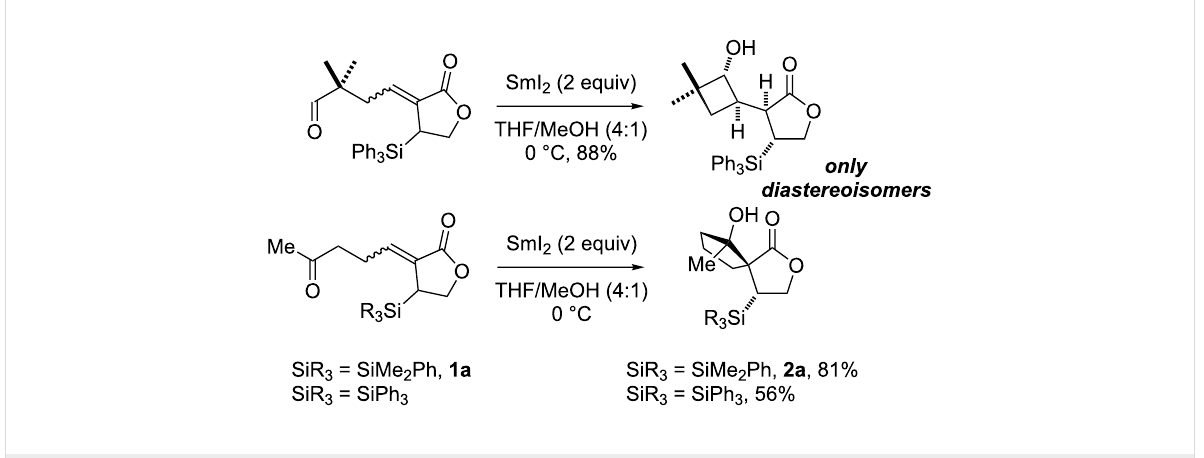
Scheme 1: SmI 2 -mediated cyclisations directed by a C–Si